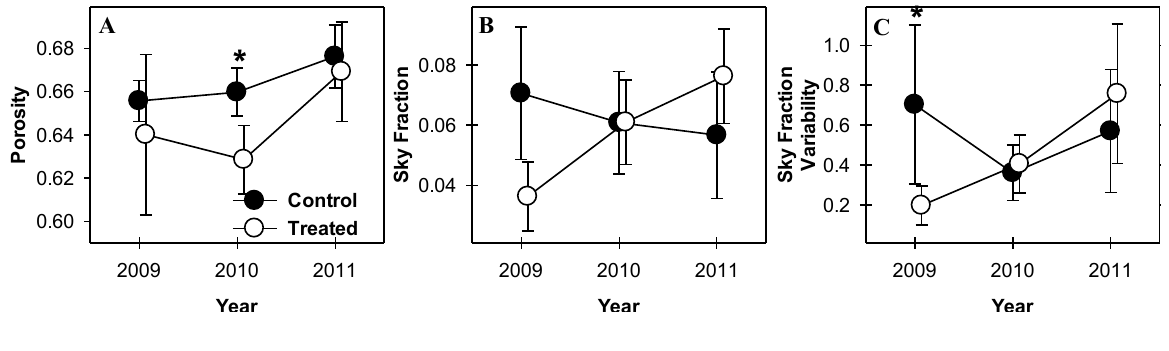
Figure 3. Porosity and canopy sky fraction mean and variation. Porosity ( A ) of treated plots temporarily declined from 2009 to 2010 and was significantly lower than control stands in 2010. Sky fraction ( B ) and variability of sky fraction ( C ) increased in treated stands in all years following girdling. Values are means of paired treated and control plots with standard error bars representing between-plot variation. * indicate significant differences between treated and control plot